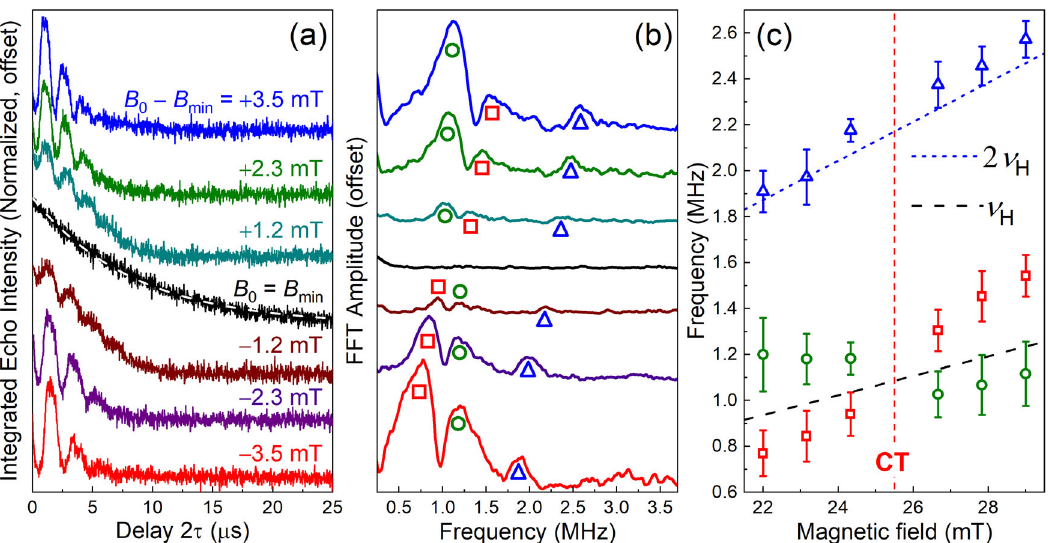
Fig. 2 Experimental HoW 10 ESEEM spectra. a Electron spin-echo decay curves recorded at 9.18 GHz and 5 K as a function of detuning, B 0 (cid:2) B min (see labeling); the white dash curve is fi t to a mono-exponential decay for zero detuning ( B 0 ¼ B min ), from which the optimum T m = 8.43(6) μ s is deduced. b FFTs of the decay curves in (a), presented in the same order; prominent peaks in the ESEEM spectra are marked with red squares, green circles, and blue triangles. c Plot of the FFT peak frequencies in ( b ) versus B 0 , with error bars denoting ± s.d. (approximating each peak as a Gaussian); the dashed lines correspond to harmonics of the proton Larmor frequency (see legend), the data points are color/shape coded according to the same scheme as those in ( b ), and the vertical dashed red line marks the clock transition